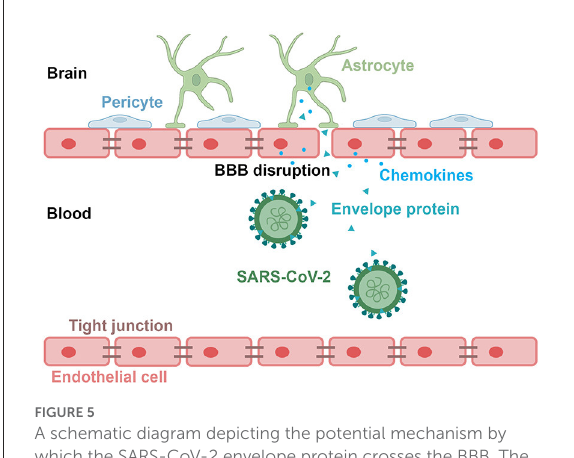
FIGURE5 A schematic diagram depicting the potential mechanism by which the SARS-CoV-2 envelope protein crosses the BBB. The S2E protein disrupts BBB integrity, leading to inflammation in endothelial cells and